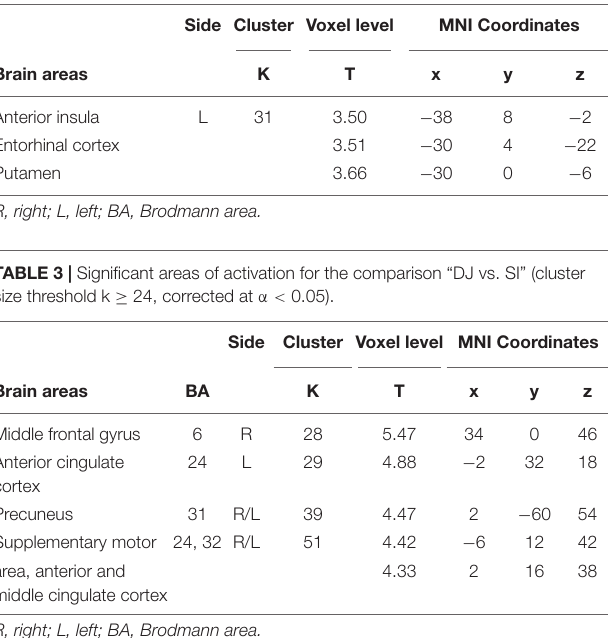
Brain areas BA K